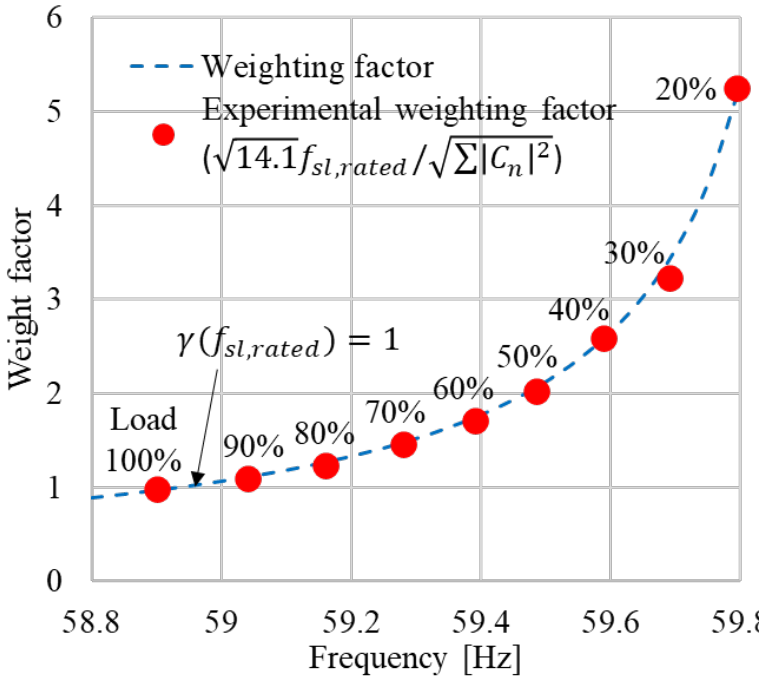
Figure 8. Weighting factor versus frequency of the Fourier series coefficient.